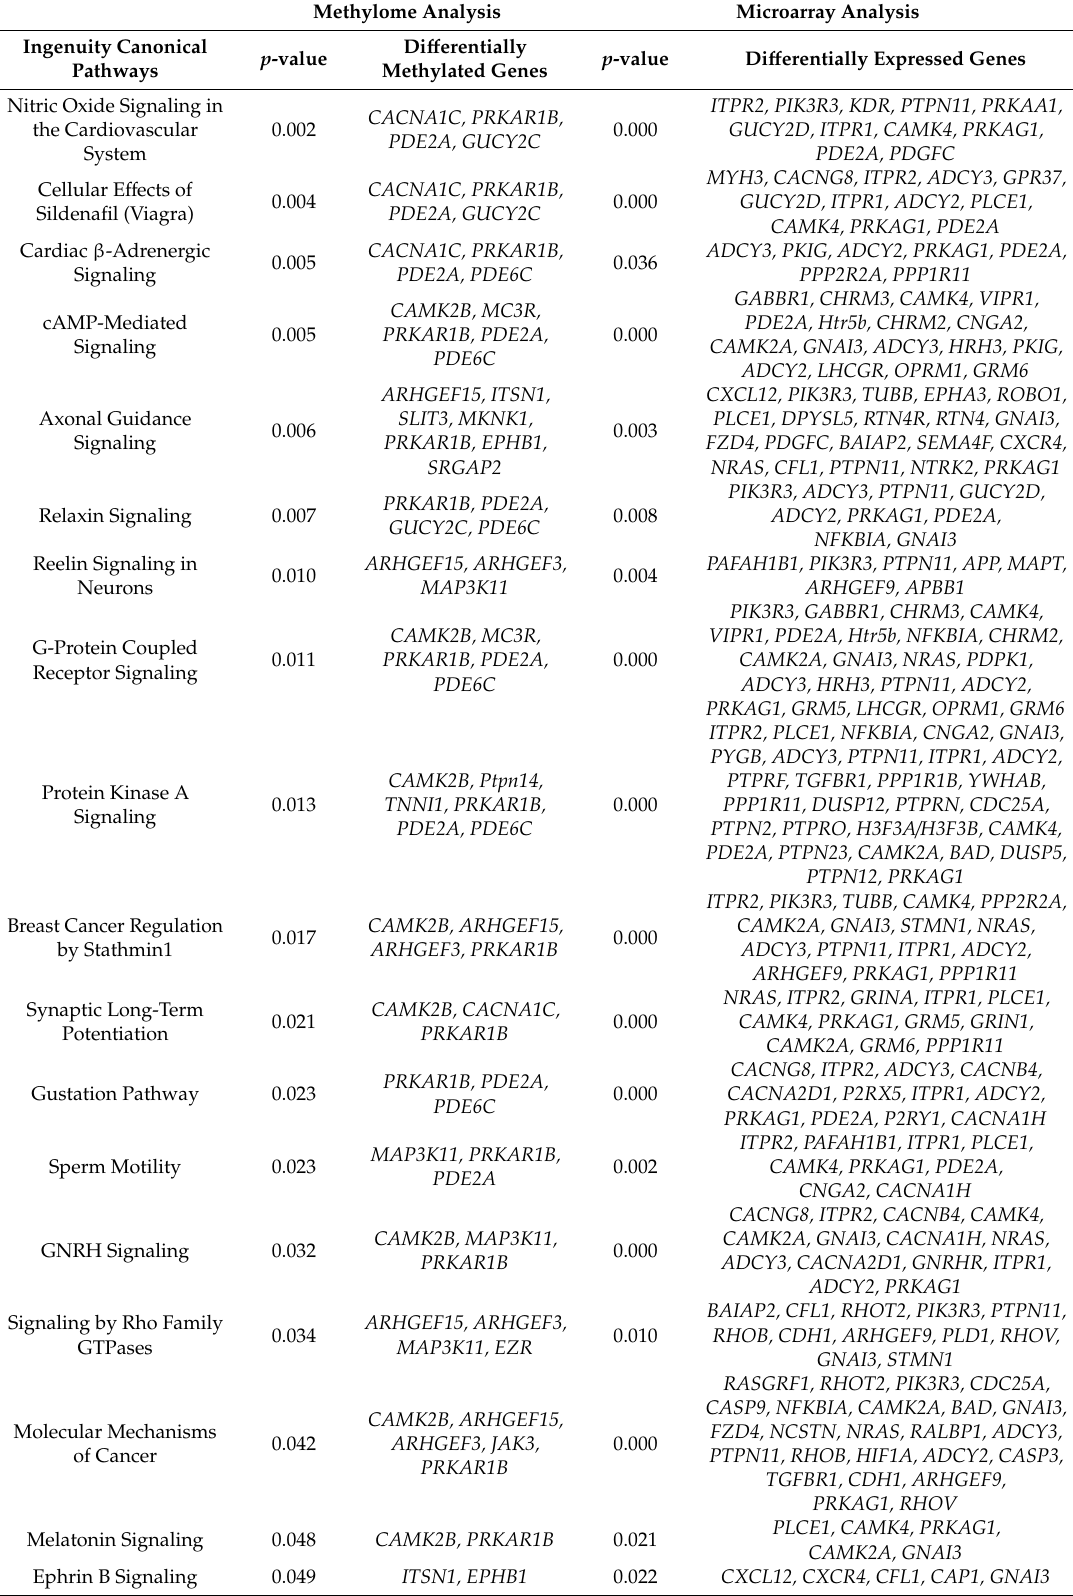
Table 3. Overlapping canonical pathways of the P15 DNA methylome and P15 microarray